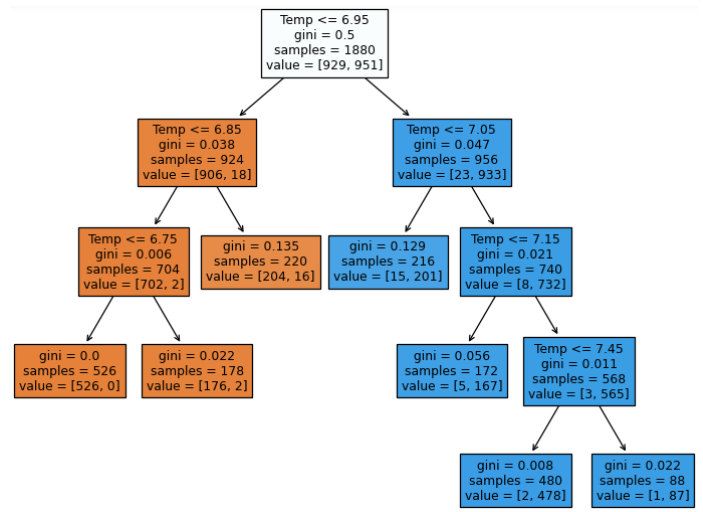
Figure 9. Chiller DT without Pruning.